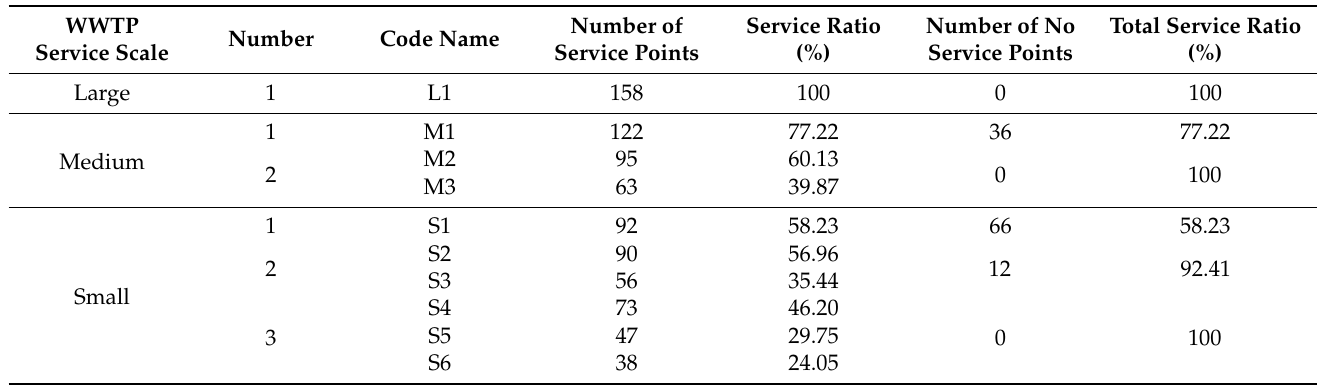
Table 7. New WWTPs results.